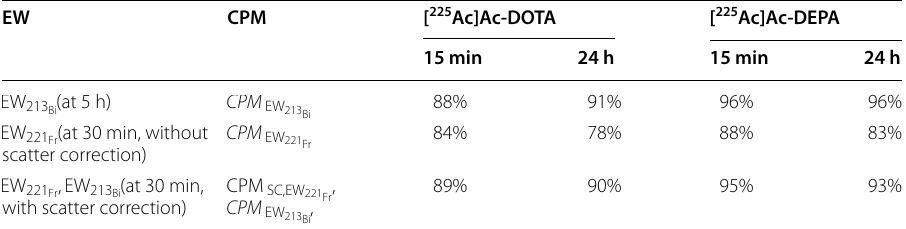
Table 3 Bound fraction of 225 Ac (activity upper part iTLC/activity iTLC) to [ 225 Ac]Ac‑DEPA/DOTA complexes for samples 5 and 6 (see Table 1) after 15 min and 24 h incubation in human serum